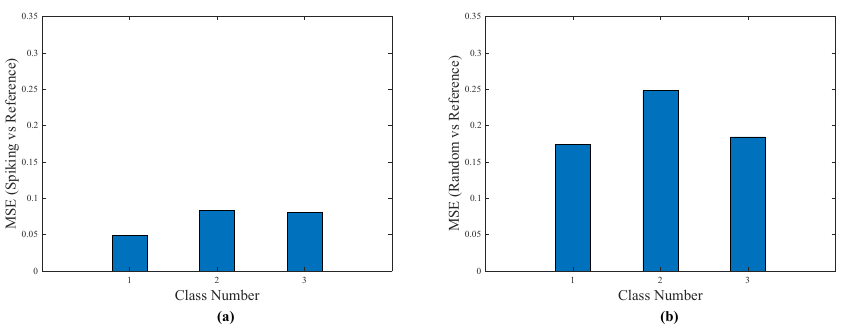
Figure 11. MSE values. ( a ) MSE-1: Spiking versus Reference. ( b ) MSE-2: Random versus Reference.